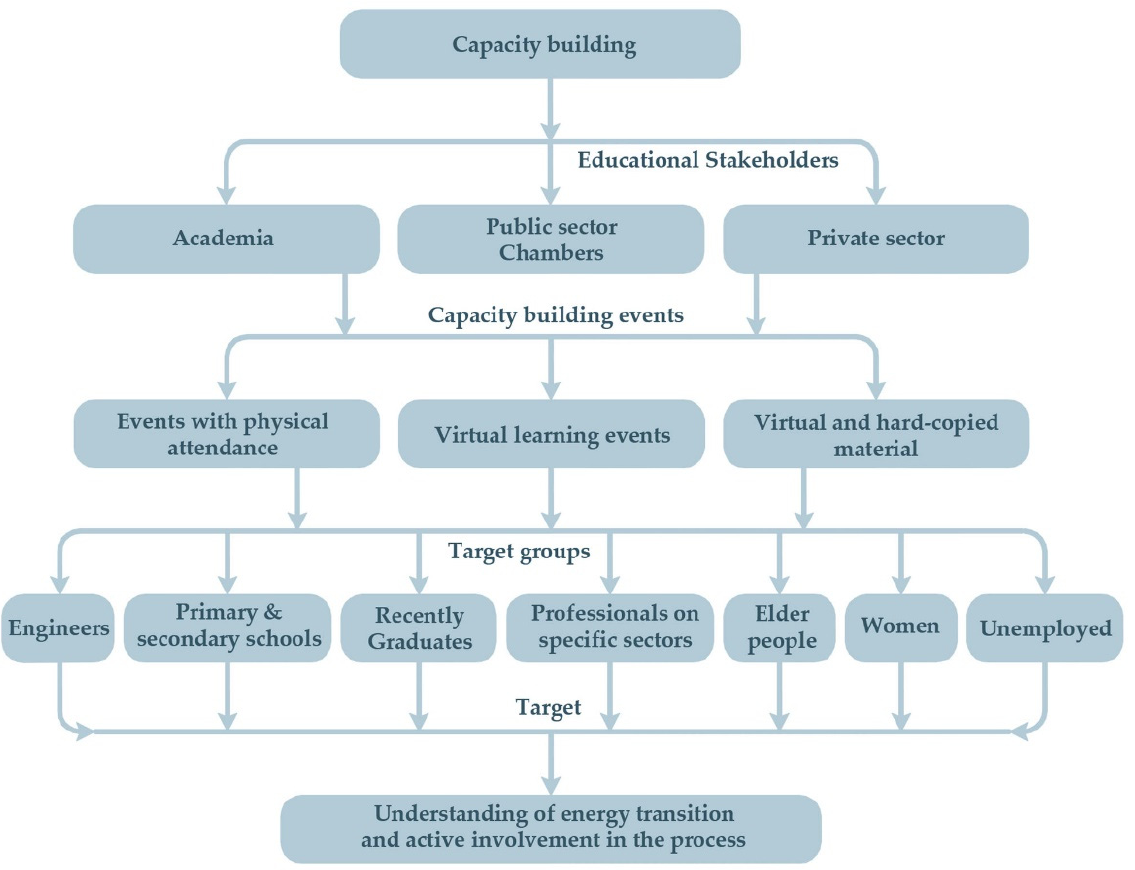
Figure 12. Suggested roadmap for the successful and effective implementation of capacity building in rural areas such as Crete Island, Greece.